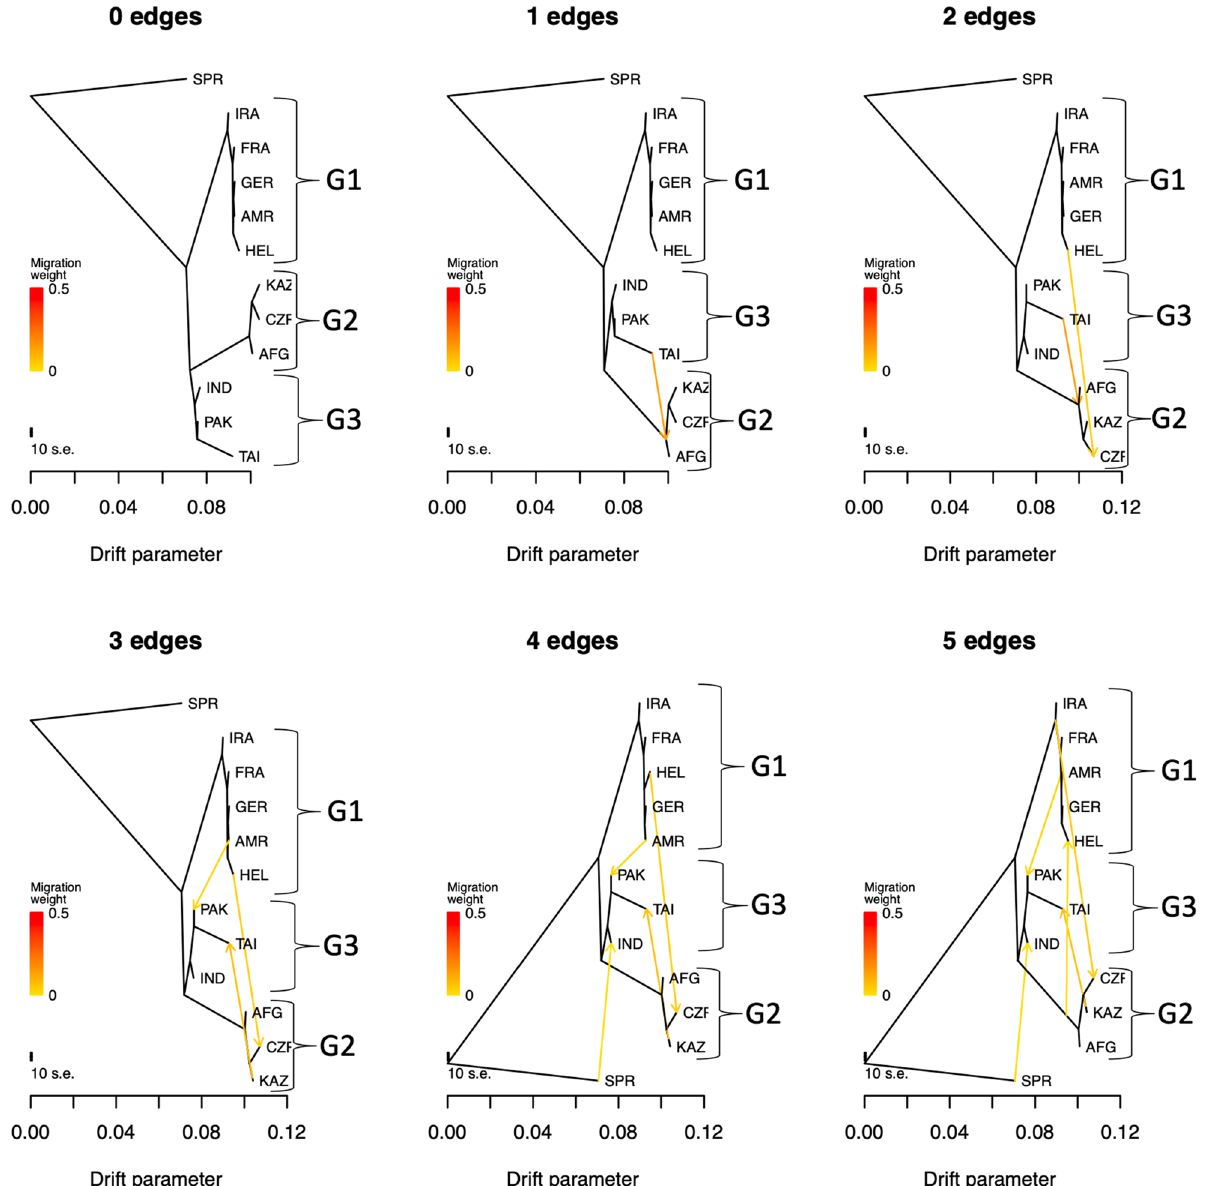
Figure 3. Phylogenetic relationships from TreeMix between house mouse populations. Treemix models the effect of different numbers of populations experiencing gene flow and different pairwise migration rates between populations. Zero edges correspond to the absence of gene flow. Under all considered scenarios, HEL is embedded within the taxonomic group G1 ( M. m. domesticus ) and PAK in G3 (corresponding to M. m. castaneus populations). M. spretus (SPR) was used as an